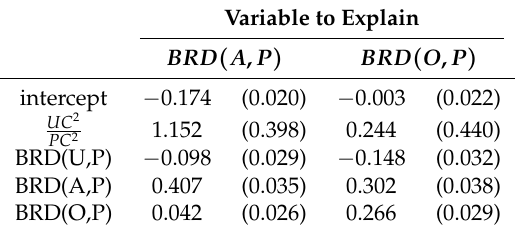
Table 12. The results for the regressions to predict better analysts in the evaluation sample using variables in the evaluation sample. This is based on 1835 forecasters (since we only include forecasters with a minimum of 10 observations in both sample periods) with a total of 52,236 forecasts in the estimation sample and 36,403 forecasts in the evaluation sample. We put the data across all firms in one regression. We used two interpretations for what a better analyst is: an analyst that has a smaller forecast error compared to the predicted component (“better performing”) and an analyst whose associated optimally constructed forecasts have smaller forecast errors compared to the predicted component error (“having more information”). These might overlap if the forecasters with more information also used them well (so if the optimal forecast is similar to the analyst forecast), but there could also be forecasters that do not use their information well, which is why we separate these − y measures. In these regressions we used the balanced relative difference: BRD ( x , y ) = x with x and y x + y being combinations of A (for the analyst forecast error, FE 2 ), P (for the predictable component error, PCE 2 ), O (for the optimal forecast error, OE 2 ) and U (for the squared unpredictable component, UC 2 ). As performance variable, we used BRD ( A , P ) , while we used BRD ( O , P ) as information variable. The variables to be explained were measured in the evaluation sample, while the regressors were measured in the estimation sample. Standard errors are shown in parentheses. Short conclusion: (1) Better performing forecasters (low value of BRD ( A , P ) ) can be predicted by looking at historically better performing forecasters and at forecasters that have relatively small unpredictable components (compared to PC 2 ); and (2) forecasters that have more usable information (low value of BRD ( O , P ) ) can be predicted by looking at forecasters that historically have more information and forecasters that performed better. Variable to Explain BRD ( A , P ) BRD ( O , P ) intercept − 0.174